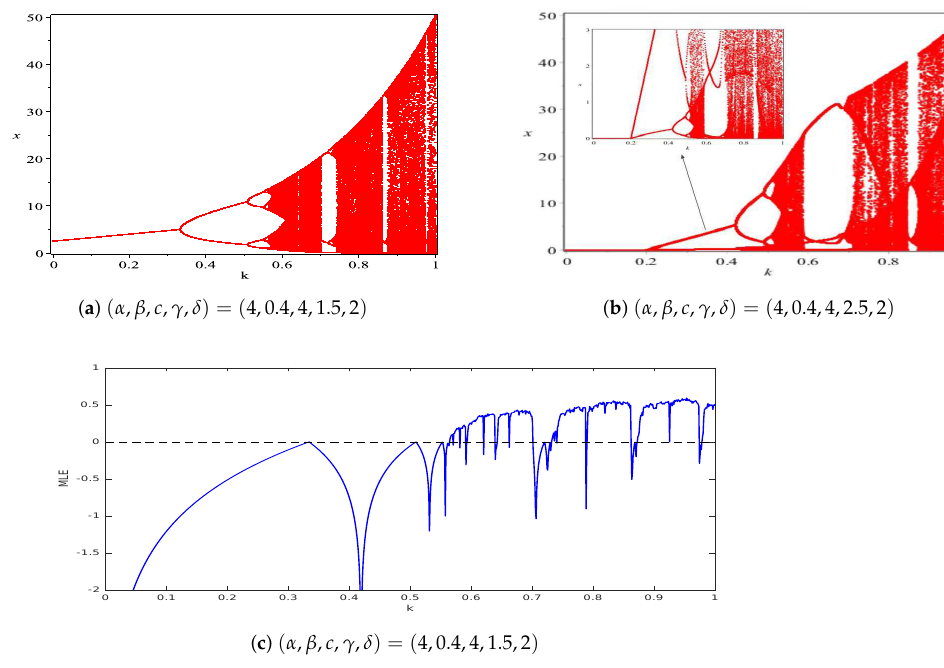
Figure 5. ( a , b ) Bifurcation diagrams of system (4); ( c ) the maximum Lyapunov exponent of the positive fixed point of system (4).